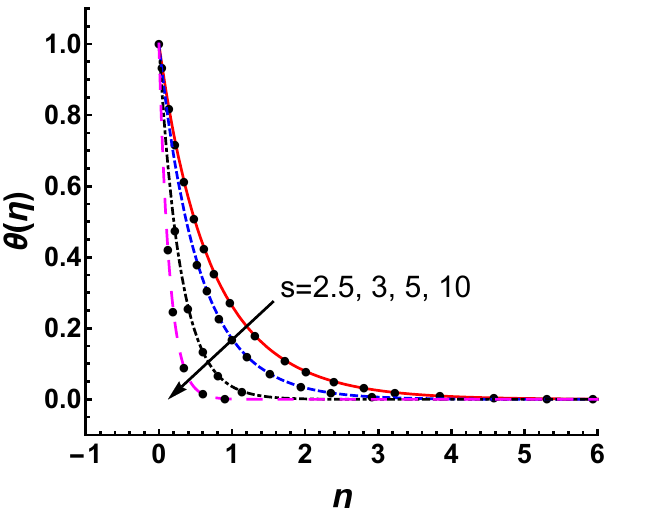
Figure 11. Influence of s parameter on temperature profile θ ( η ) with γ = s = 1, Pr = 0.71; line: HAM results, marker: numerical results.